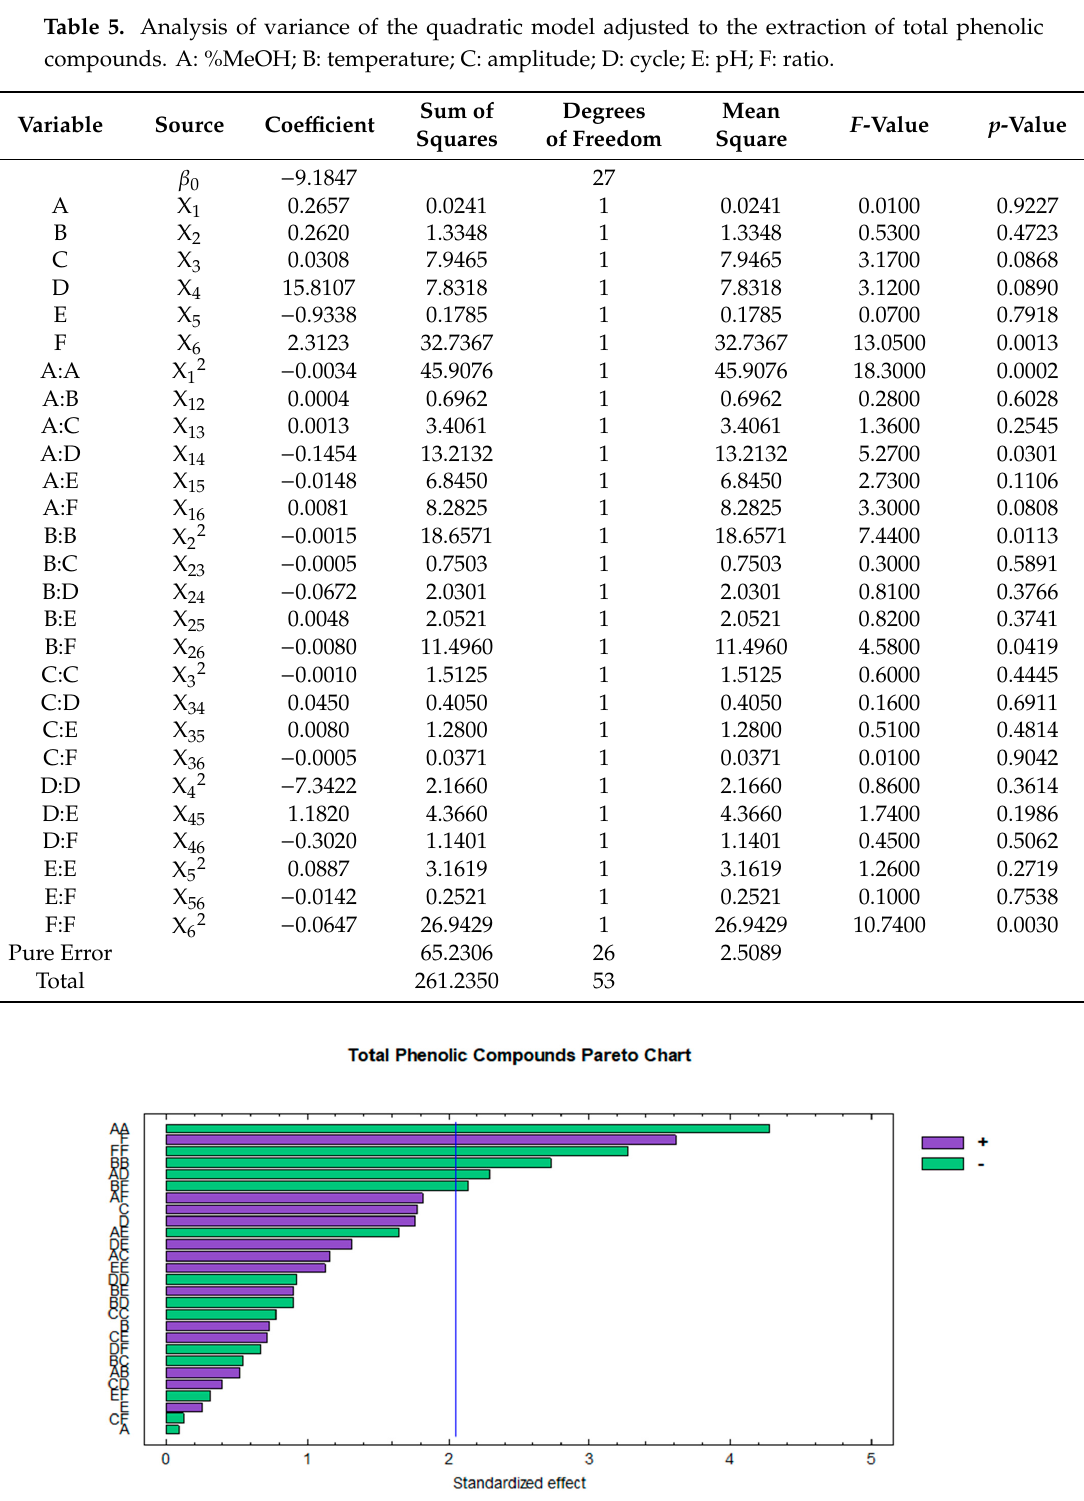
Figure 4. Standardized Pareto chart representing the optimization of total phenolic compounds extraction. A: solvent (% MeOH); B: temperature (°C); C: amplitude (%); D: cycle (s); E: pH; F: ratio (mL).